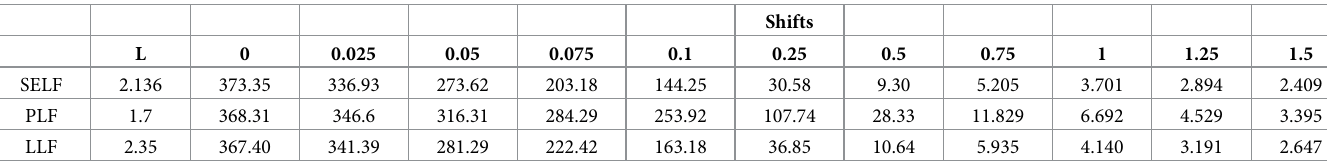
Table 4. ARLs of existing Bayesian EWMA chart for n = 5 and λ = 0.15 under various loss function for ARL 0 =